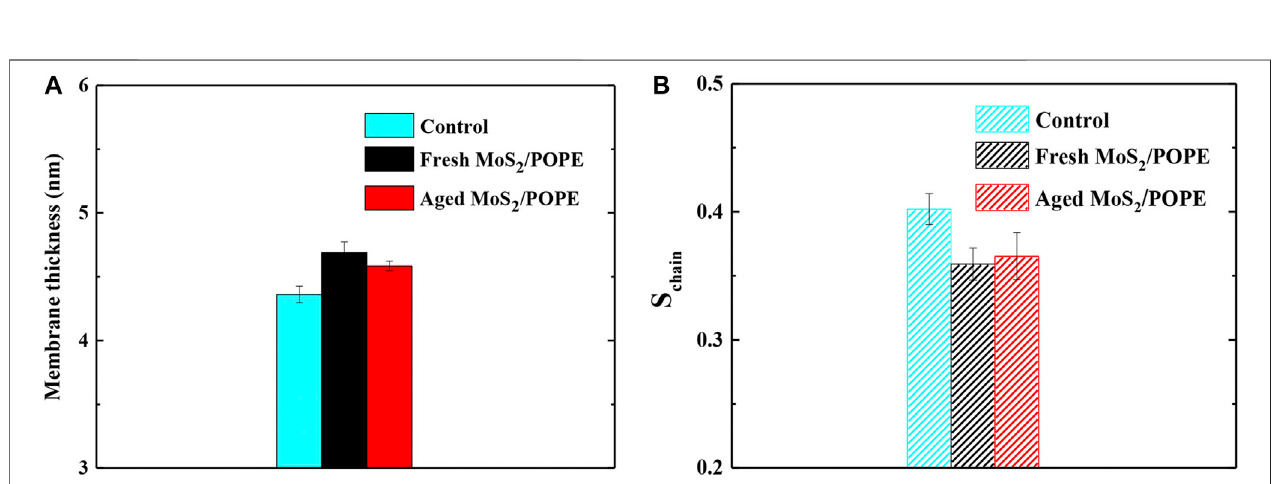
FIGURE6| Insertionsofthefresh/agedMoS 2 nanosheetcausestructuraldamagetothePOPElipidmembrane. (A) Theaveragethicknessand (B) lipidtailorderof POPE membrane over the last 10ns trajectories from fi ve independent simulations.